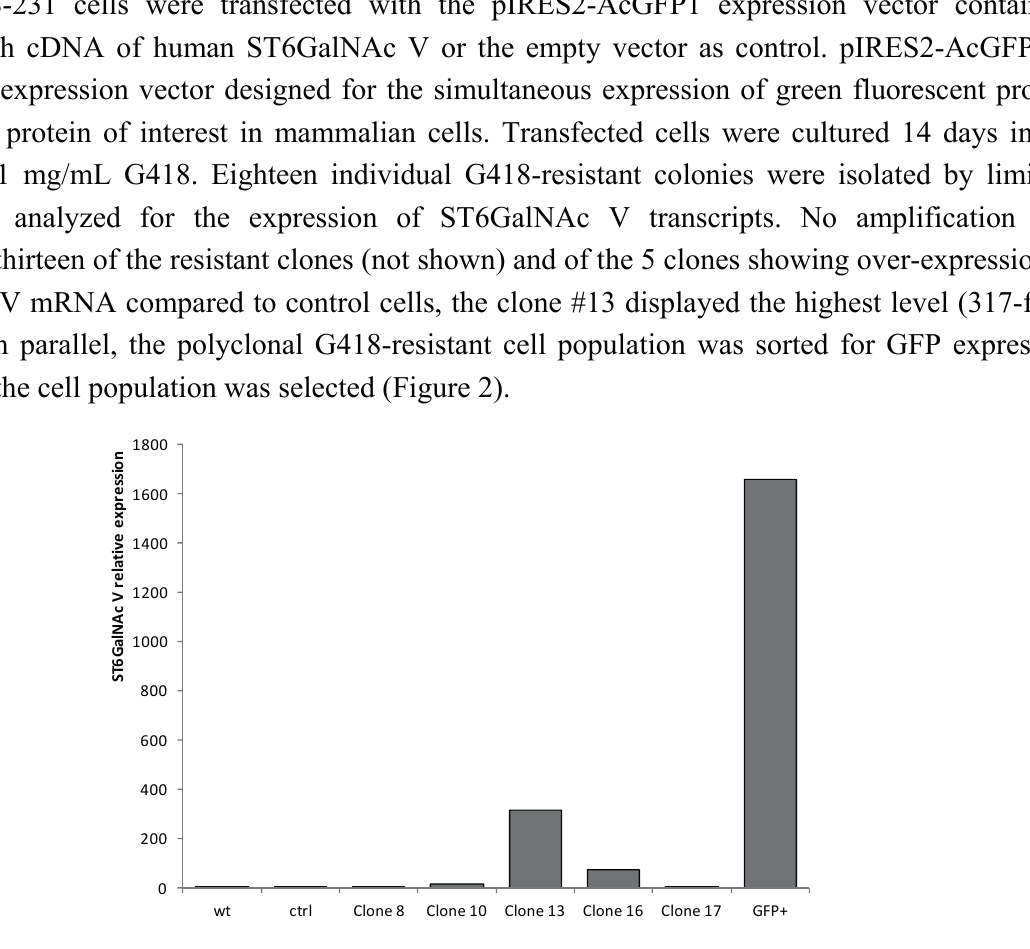
Figure 1. QPCR analysis of ST6GalNAc V expression in control and